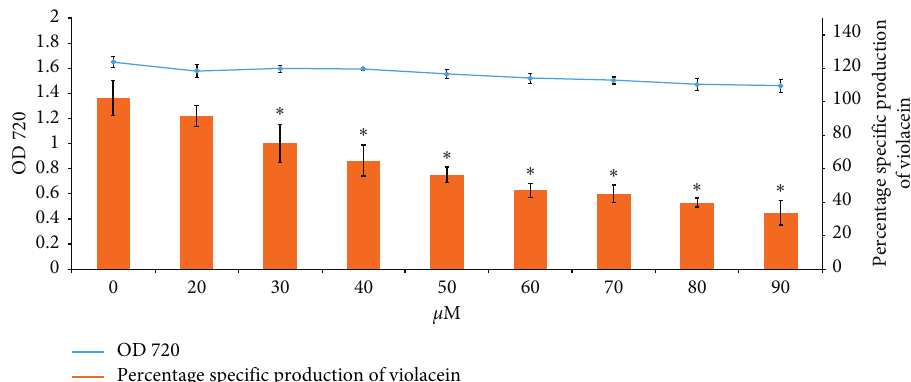
Figure 3: Bacterial growth (OD720 nm) and percentage of violacein production (mean ± SE; n � 6) in Chromobacterium violaceum CV026 when exposed to different concentrations (0–100 μ M) of 13 . Asterisks indicate statistically significant activity ( p < 0 . 05, calculated with ANOVA).